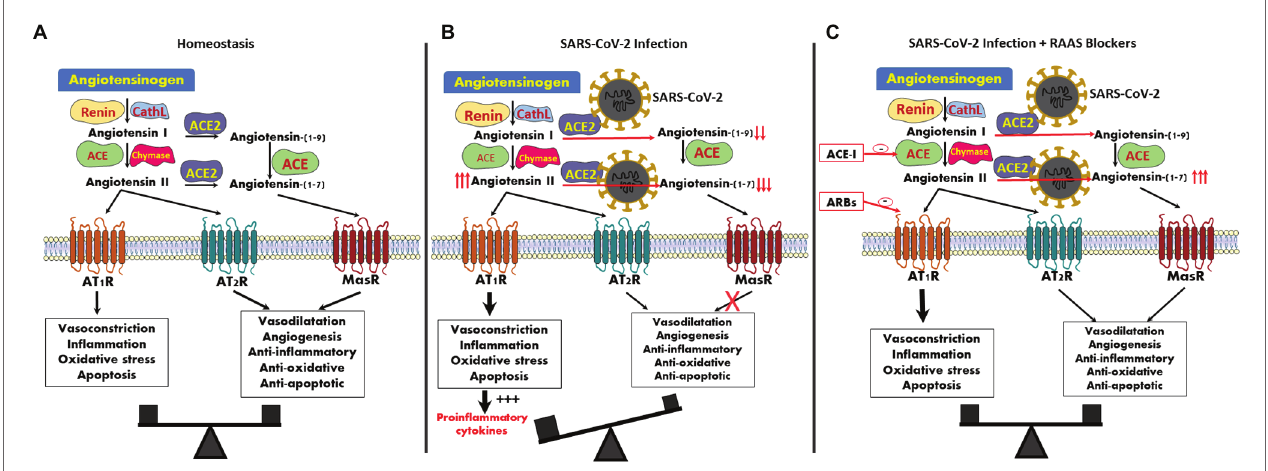
FIGURE 1 | Angiotensin derivatives, their targets and downstream action: (A) Balanced impact of angiotensin (Ang) II and Ang 1-7 on vascular tone and control of inflammation. (B) SARS-CoV2 infection generates Ang 1-7 depletion, likely leading to unopposed vasoconstriction and inflammation. (C) Concomitant renin-Ang- aldosterone system (RAAS) inhibition with Ang-converting enzyme (ACE) inhibitors or Ang-receptor blockers (ARBs) may restore the balance, with parallel suppression of signals mediated by Ang T 1 receptors (AT1R) and Mas receptor